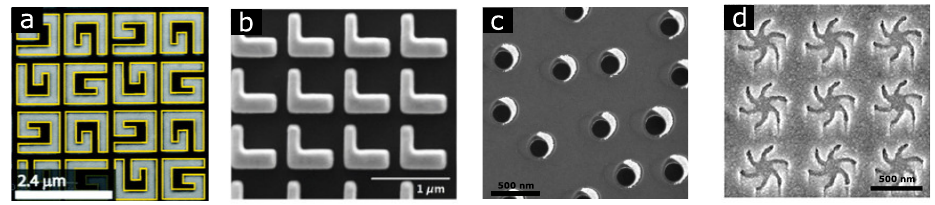
Figure 5. Examples of planar chiral nanostructures: ( a ) arrays of G-shaped gold nanoparticles. Adapted with permission from Valev et al. [89] Copyright 2009 American Chemical Society. ( b ) Arrays of L-shaped gold nanoparticles. Adapted with permission from Ye et al. [91] Copyright 2017 American Physical Society. ( c ) Short-ordered arrays of comma-shaped gold nanoparticles [94]. ( d ) Gold metafilm with arrays of “Shuriken” nanostructures. Adapted with permission from Kelly et al. [98] Copyright 2018 American Chemical